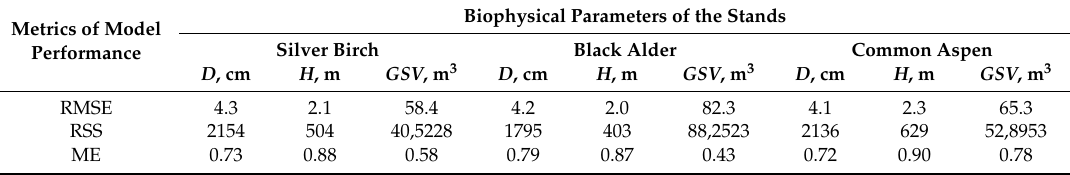
Table 4. Accuracy of developed growth